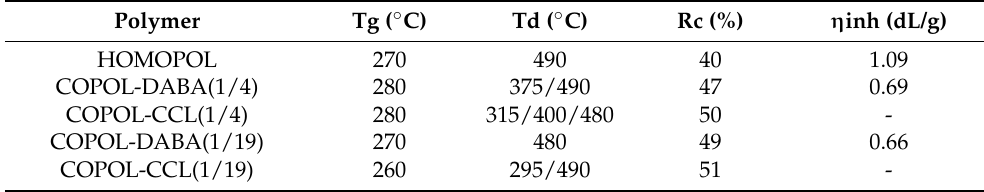
Table 4. Glass transition temperatures (Tg), degradation temperatures (Td), and char yield (Rc) at 800 ◦ C, under nitrogen atmosphere, of homopolymer and copolyimides, and crosslinked polyimides. Inherent viscosity ( η inh) values of homopolyimide and